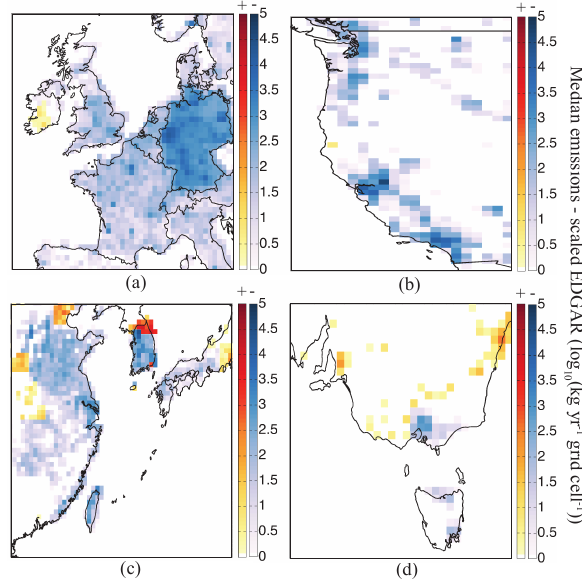
Fig. 3. Difference between derived 2012 SF 6 emissions and the scaled EDGAR emissions for regions around (a) Mace Head, Ire- land; (b) Trinidad Head, USA; (c) Gosan, South Korea; and (d) Cape Grim, Australia. Positive differences are shown by the red log- arithmic color map and negative differences by the blue logarithmic color map.